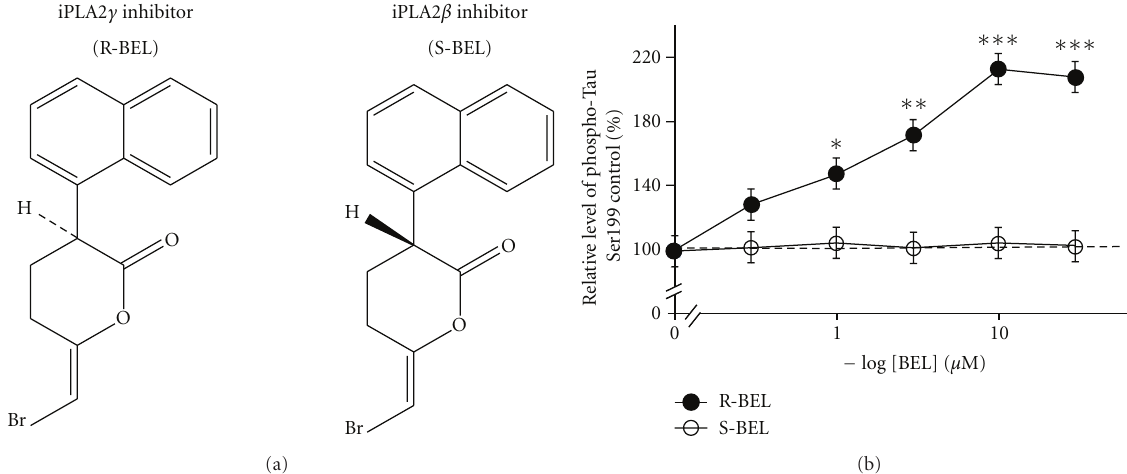
Figure 1: Hippocampal Tau phosphorylation at Ser199 residue is accentuated by R-BEL. Hippocampal slices (350 μ m) were pre-incubated at 32 ◦ C for 3h with DMSO alone (control) or with increasing concentrations of the iPLA 2 γ inhibitor R-BEL or the iPLA 2 β inhibitor S-BEL (chemical structures of both compounds are presented in (a)). (b) Phosphorylation and Tau protein levels were determined by Western blotting of cell extracts (40 μ g of proteins) obtained from acute hippocampal slices. Phosphorylated Tau levels, expressed relative to total Tau (i.e., Tau-5; AbCam, Cambridge, MA, USA. Dilution 1: 500), were measured using antibodies raised against Tau phosphorylated at Ser199 (AbCam, Cambridge, MA, USA. Dilution 1 :1,000). The data were expressed as percentage of control values and are means ± SEM of 3 measurements per cell extract obtained from 7 di ff erent rats. Statistical analysis was performed by one-way ANOVA followed by Neuman- Keuls’ post hoc test. ∗ P < 0 . 05, ∗∗ P < 0 . 01, ∗∗∗ P < 0 . 001, drug-treated versus